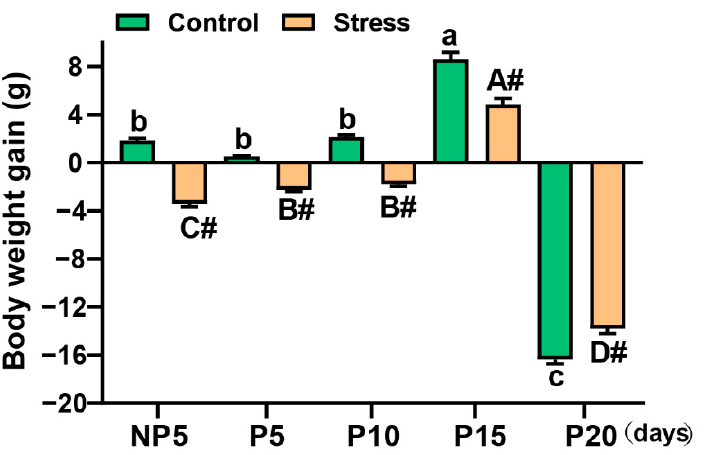
Figure 1. Changes in body weight after restraint stress. Restraint stress caused a significant decrease in the weight gain of pregnant mothers. The data are expressed as the mean ± standard error of mean (SEM). # was used to denote extremely significant difference between stress and corresponding control groups ( p < 0.01). Uppercase letters in the column (A, B, C, D) represent the differences between different ages in the stress group ( p < 0.05). A (in the P15 group) represents the biggest value in the stress. Lowercase letters in the column (a, b, c) represent the differences between different ages in the control group ( p < 0.05). a (in the P15) represents the biggest value in the control. Treatment groups are significantly different from each other if no labelling letter (a to e or A to E) is shared between groups. The X axis represents the days of pregnancy, NP5: Non-Pregnancy Day 5, P5: Pregnancy Day 5, P10: Pregnancy Day 10, P15: Pregnancy Day 15, P20: Preg-